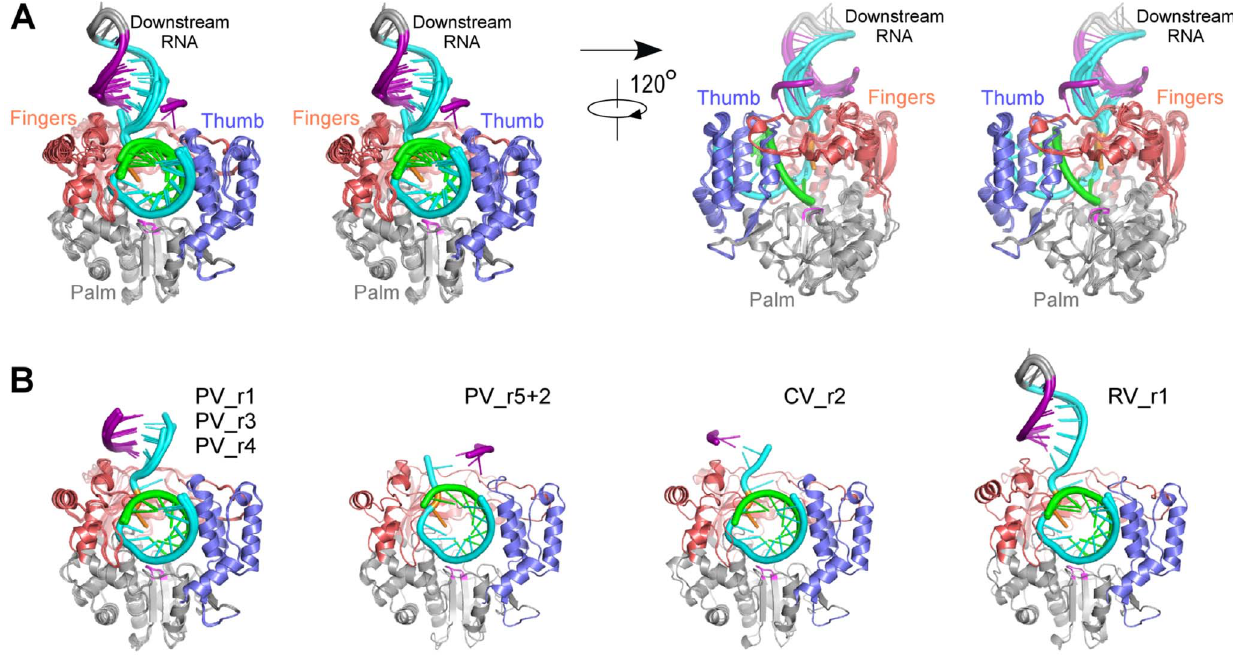
Figure 4. Comparison of EC structures and downstream RNA conformations. A) Stereo images of all eight picornaviral EC superimposed and shown in orientations along the upstream product duplex (left) and looking into the NTP entry channel (right). The RNA is color coded as in Figure 1 and polymerases follow the three-color coding scheme with the active site YGDD residues shown in magenta. Upstream product duplex RNA nucleotides that are completely outside of the front channel (position 2 9 and beyond) are omitted for clarity. Note that the position of the downstream RNA duplex, protruding from the fingers domain, is consistent in all complexes except for PV_r5 + 2 where this RNA is rotated by almost 180 u and the 5 9 end is positioned above the thumb domain. B) ECs grouped according to virus species. From left to right: four PV complexes that are consistent in both polymerase and RNA conformation (two ECs from PV_r1 crystals); one PV complex that differs significantly from other PV complexes in downstream RNA conformation; one CV complex; two RV_r1 complexes that are differ slightly in downstream RNA conformation due to differences in crystal contacts (see Figure 2B).